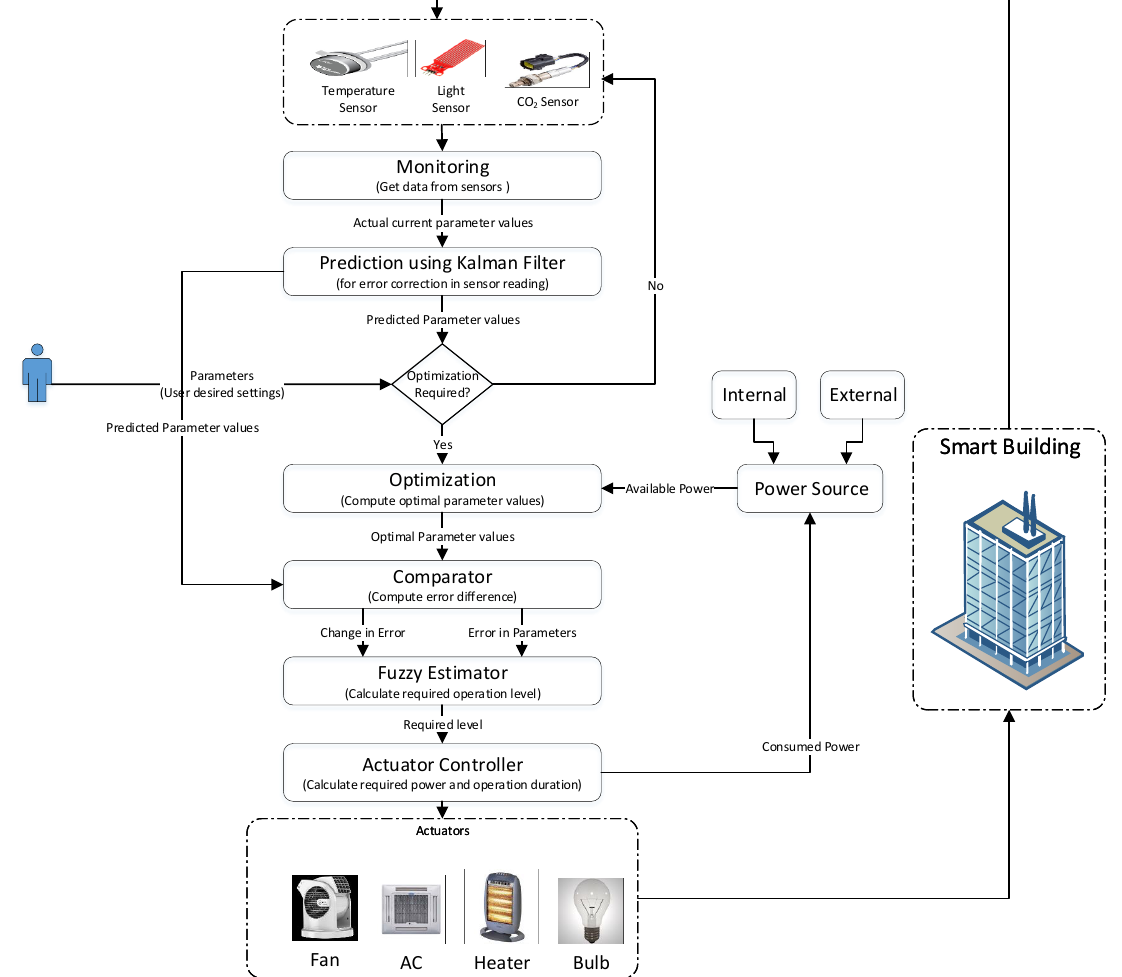
Figure 3. System flow diagram for the smart energy management